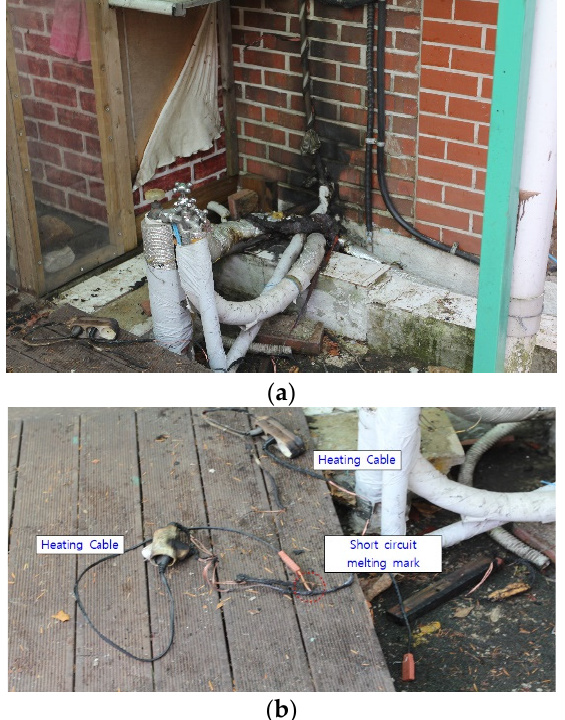
Figure 6. Case of fire caused by heating cables wrapped around water service pipes and thermal insulation or taping on the outside. ( a ) Case 1—Fire site ➀ . ( b ) Case 1—Fire site ➁